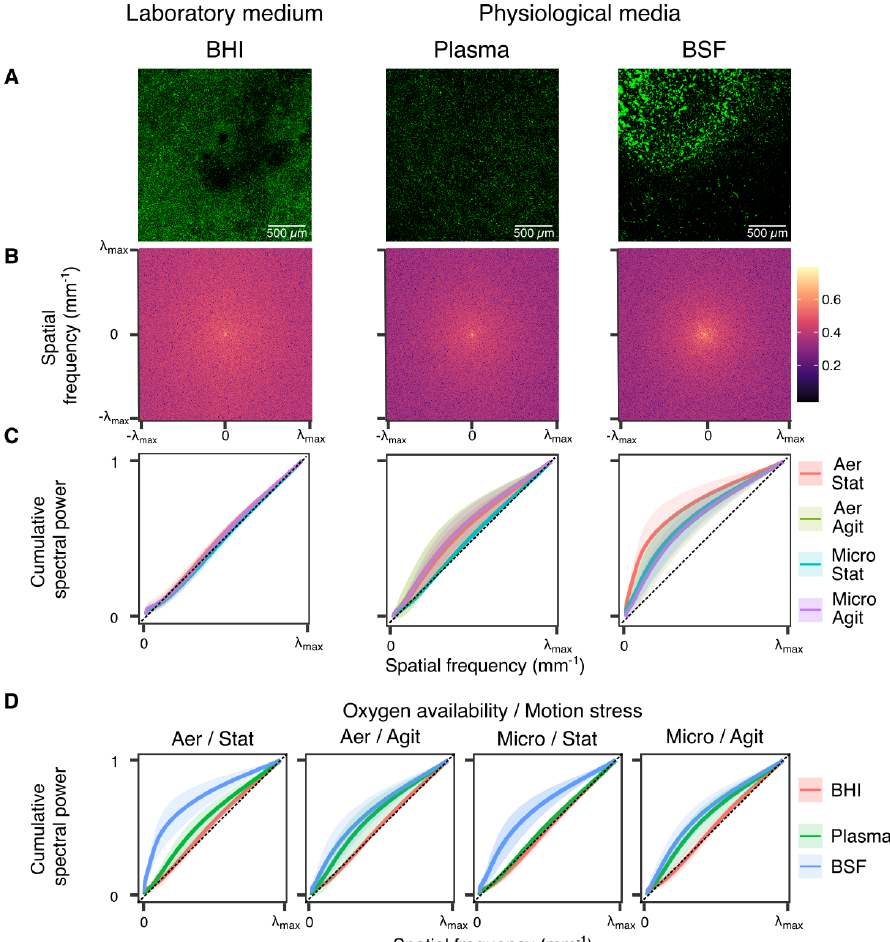
Figure 4. Fourier analysis reaffirms significant differences in biofilm pattern formation between lab and physiological media. ( A ) Representative CLSM images of sessile biofilm attachment to a titanium disk submerged in laboratory medium (BHI) or in physiological media (plasma, BSF). ( B ) Two-dimensional Fourier power spectrum of the representative CLSM images in ( A ). ( C ) CSPfs for the same medium in different oxygen availability/motion stress conditions. ( D ) CSPfs for the same oxygen availability/motion stress condition in different